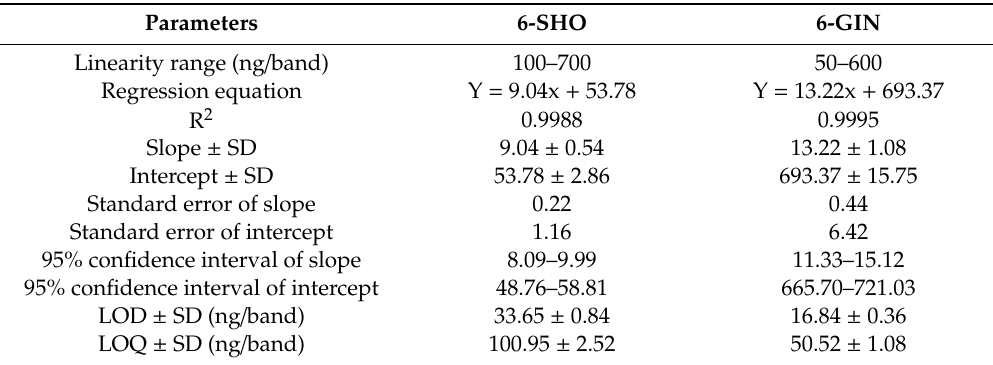
Table 1. Linear regression analysis data for the calibration curve (CC) of 6-shogaol (6-SHO) and 6-gingerol (6-GIN) for the green reversed phase high-performance thin layer chromatography (RP-HPTLC) method (mean ± SD; n = 6).